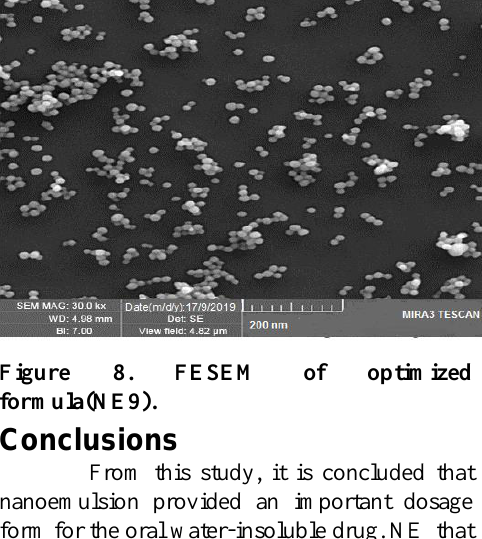
Figure 8. FESEM of optimized